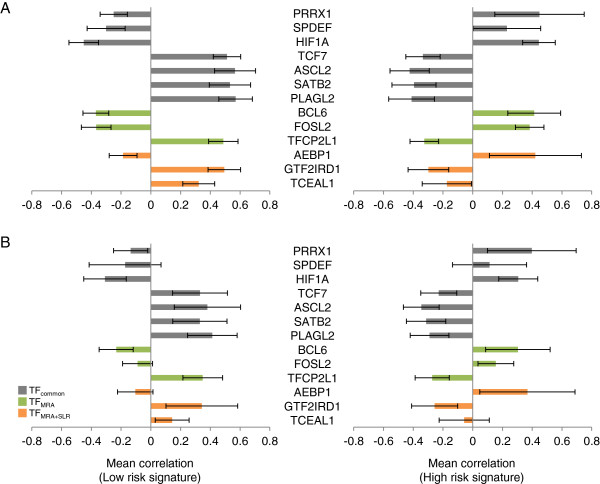
Correlation between the upstream TFs and their target genes. The average of the Spearman’s rank correlation coefficients was calculated between each of the 13 TFs (union of TFMRA and TFMRA+SLR) and the low risk (left) or the high risk (right) signature genes for (A) Moffit cohort and (B) Melbourne cohort.